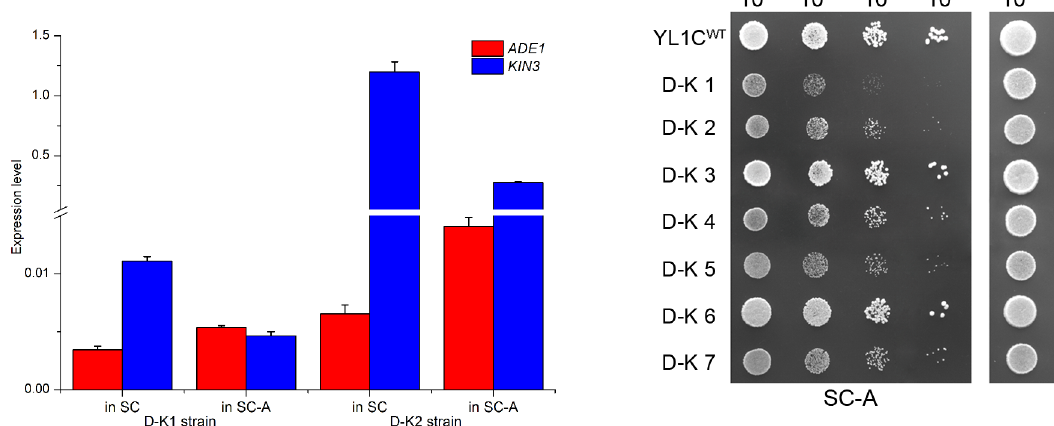
Figure 6. Anti-regulation of a convergent pair in different nutritional environments. Expression of the convergent gene pair ( ADE1 and KIN3 ) with overlapping 3 9 -UTRs in two yeast strains cultured in complete (SC) or adenine barren (SC-A) medium. Strain D-K1 has ADE1 inhibited, while strain D-K2 has KIN3 over-expressed.